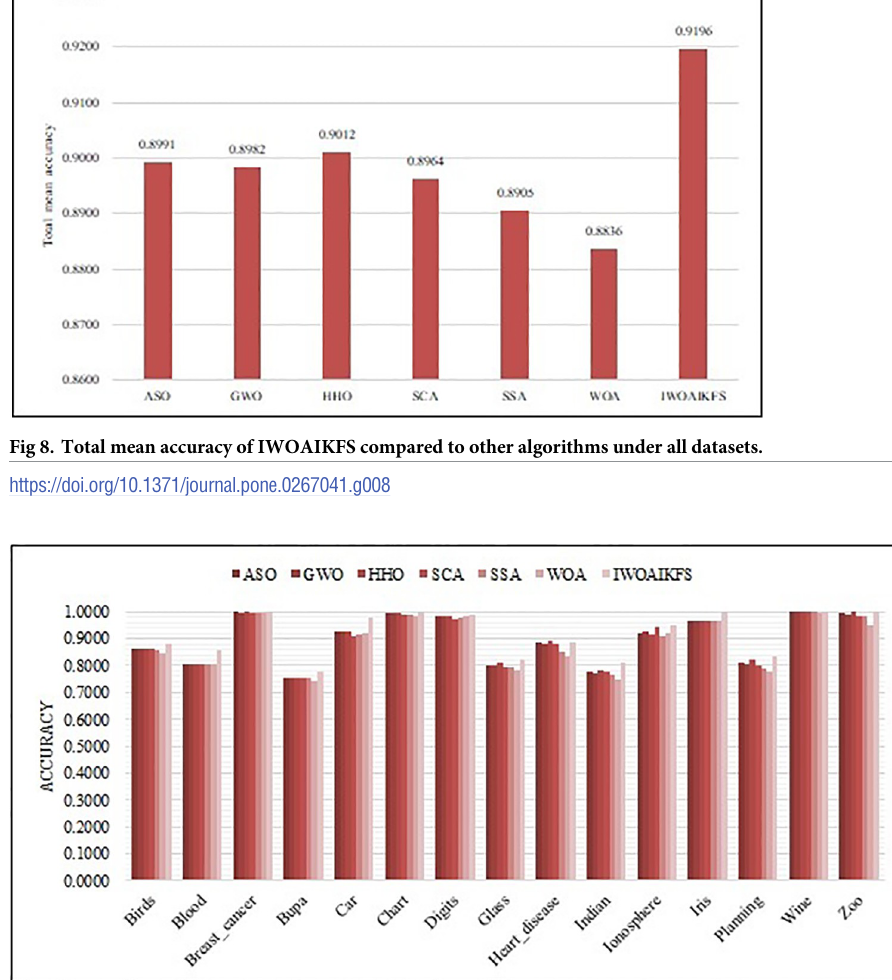
Fig 9. The accuracy of IWOAIKFS compared to other optimizers.